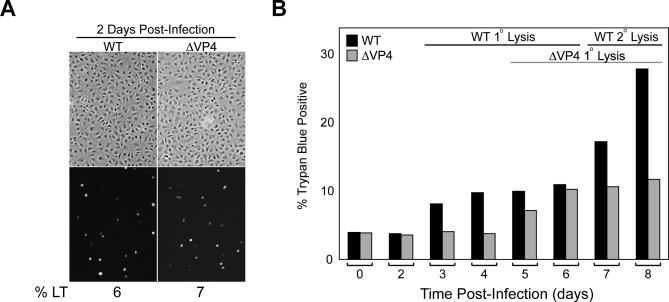
VP4 Directs the Timely Lytic Release of SV40 Progeny(A) Representative fluorescence images and the corresponding phase-contrast images displaying WT and ΔVP4 particle infectivity standardization at 2 d. The cells are stained with LT antisera and the percentage of BS-C-1 cells staining for LT is displayed below the images.(B) Removal of VP4 extends the SV40 life cycle 2 d. Trypan blue staining of ∼2,000 BS-C-1 cells at the indicated times post-infection with equivalent WT and ΔVP4 infectious particles.